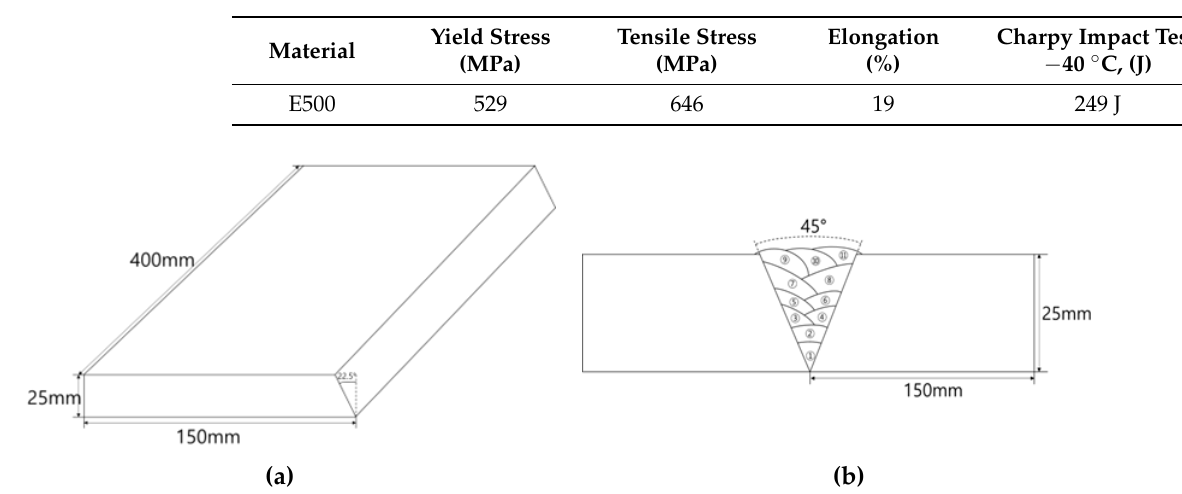
20 Table 5. Welding conditions used. Process.